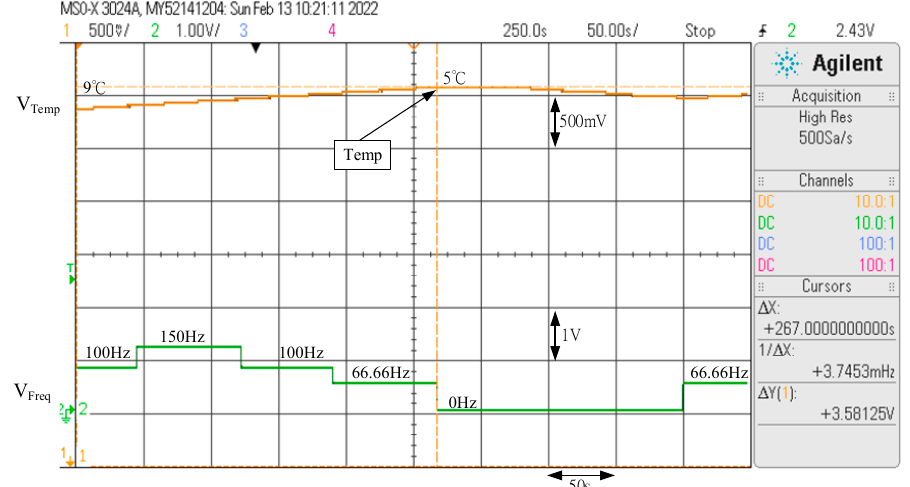
Figure 34. Response waveform of the temperature control with the conventional P-I controller (control the temperature to change from 9 °C to 5 °C).